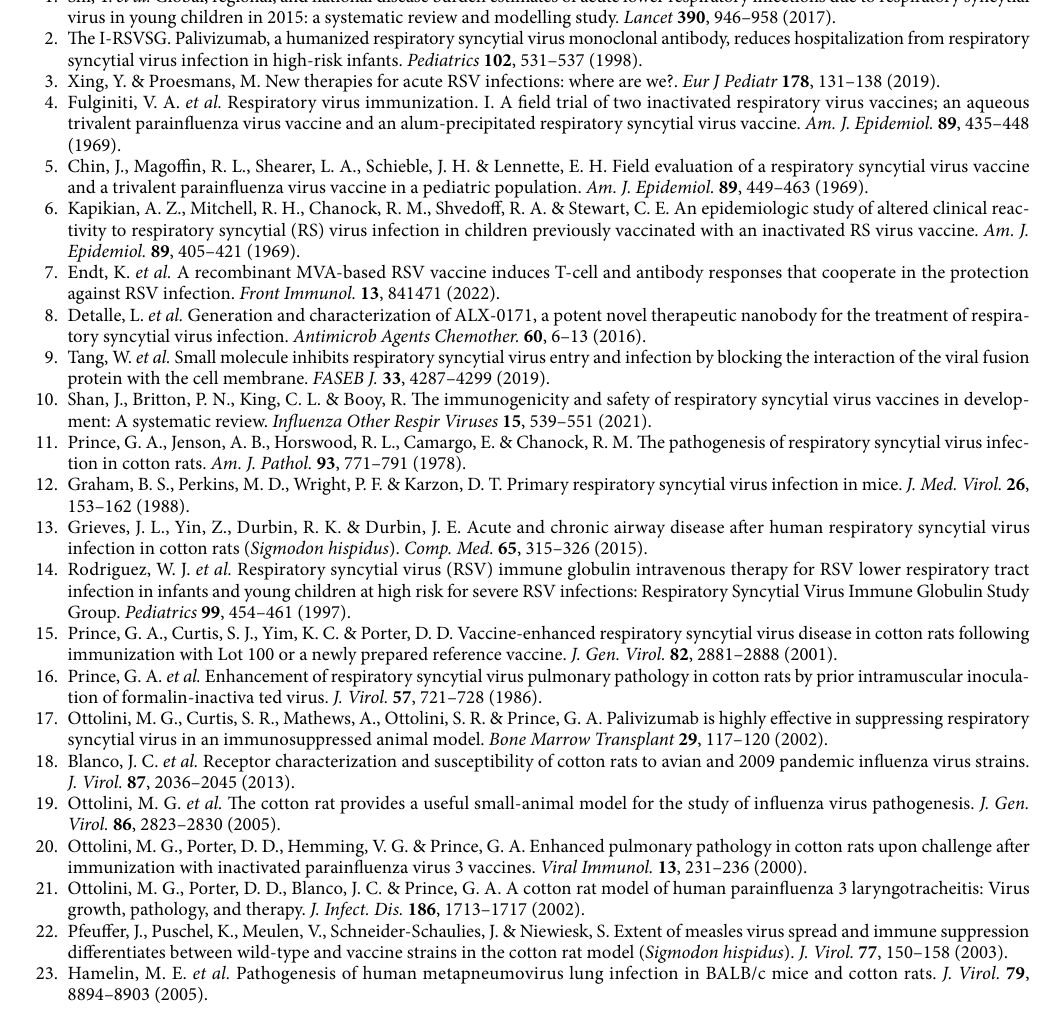
Supplementary Table 2. No-template-controls were run on each plate. Technical replicate CT values were aver- aged for each gene and normalized to β-actin housekeeping gene. Results were calculated as fold change induc- tion over uninfected lungs using the 2 −ΔΔCT method 74 . Additionally, to further confirm differential expression of genes, we compared the results of our current study to our previous annotation of the S. hispidus lung tran- scriptome upon RSV infection 27 using the same DESeq2 significance parameters ( p < 0.05, q < 0.05, l2fc >|1.0|). Ethics approval and consent to participate. No human subjects participated in this study. All animal procedures followed NIH and USDA guidelines and were approved by the Sigmovir Biosystems, Inc.